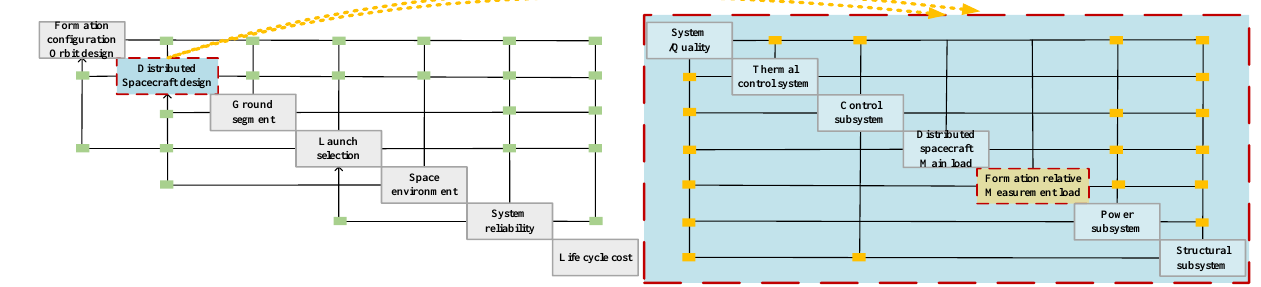
Figure 32. Design structure matrix of the overall design problem of distributed spacecraft formation flying.